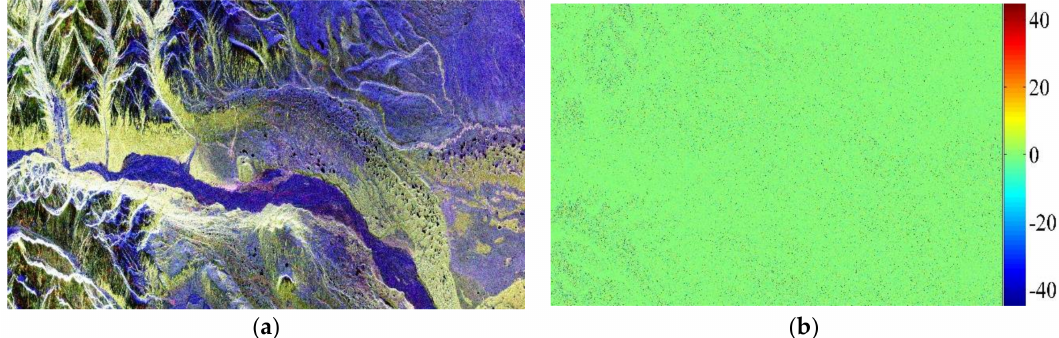
Figure 1. ( a ) ALOS PALSAR polarimetric image of a scene in Alaska (Pauli decomposition); ( b ) FRA Estimates from Alaska